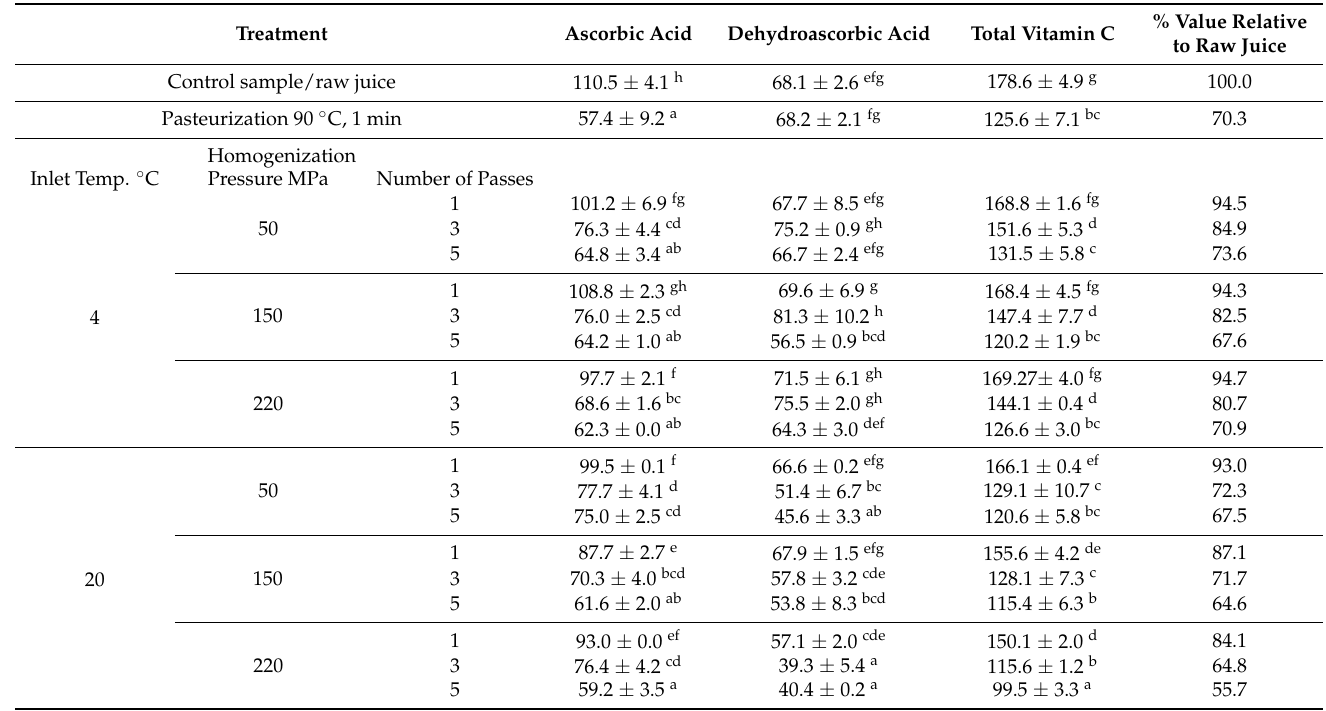
Table 3. Ascorbic acid, dehydroascorbic acid, and total vitamin C content (mg/100 mL) in cloudy blackcurrant juice samples treated with high-pressure homogenization or pasteurization. Treatment Ascorbic Acid Dehydroascorbic Acid Total Vitamin C